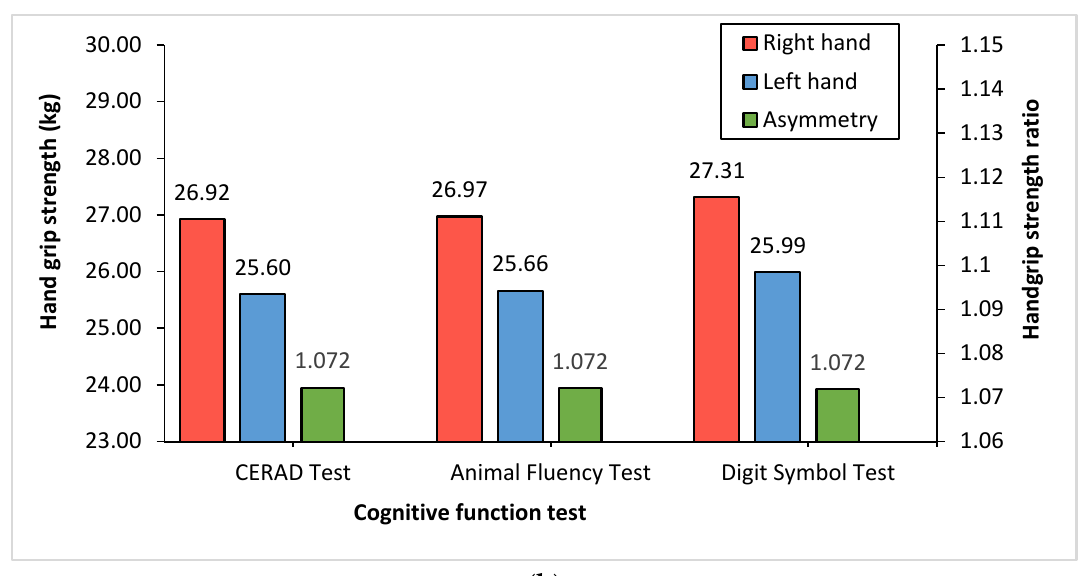
Figure 1. Right and left HGS and handgrip ratio according to cognitive function tests. The red (right hand) and blue (left hand) bars shown in Figure 1 represent the mean of HGS (kg). The green bars (asymmetry) shown in Figure 1 represent HGS ratio (dominant HGS (kg)/non-dominant HGS (kg)): ( a ) 60–69 year-old group; ( b ) ≥ 70 year-old group.